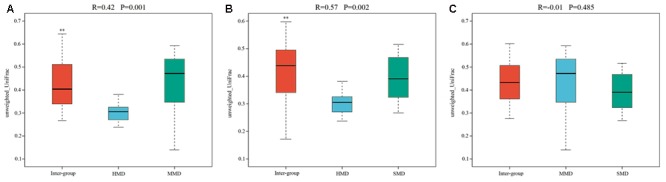
Box plot of Inter-group and Intra-group Beta distance (ANOSIM Analysis). (A) Beta distance of HMD and MMD. (B) Beta distance of HMD and SMD. (C) Beta distance of MMD and SMD. The x-axis represents the grouping and the y-axis represents the distance calculated by Unweighted_unifrac. The data in the box is the distance of Inter-group and Intra-group, respectively. R-value: R-value range (–1, 1). The R-value ≤ 0 represents no significant differences of inter-group and intra-group, and R-value > 0 shows that inter-group differences are greater than intra-group differences. P-value: the P-value represents the confidence level of the statistical analysis; ∗∗P < 0.01 reflects extremely significant differences between Inter-group and Intra-group. Boxes represent the interquartile range (IQR) between the first and third quartiles (25th and 75th percentiles, respectively), and the horizontal line inside the box defines the median. Whiskers represent the lowest and highest values within 1.5 times the IQR from the first and third quartiles, respectively.